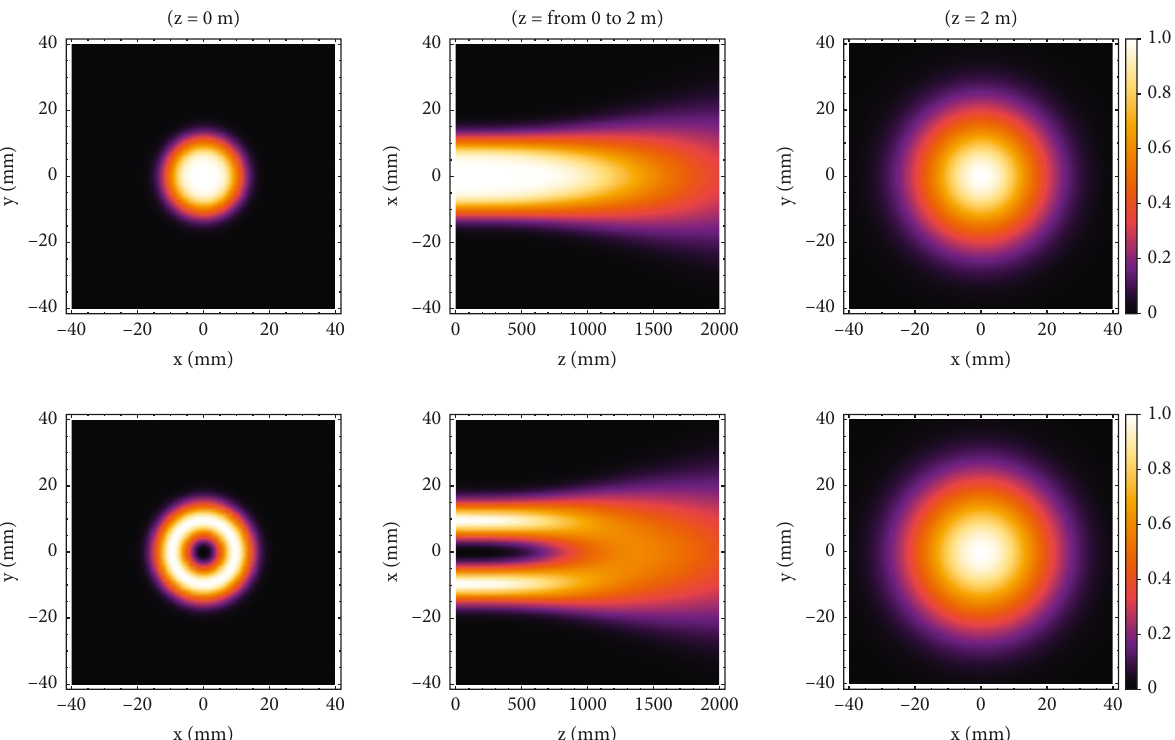
Figure 9: The intensity distribution of the partially coherent circular flat-topped nonvortex beam (top row) and vortex hollow beam (bottom row) in anisotropic turbulent plasma for different values of propagation distances z